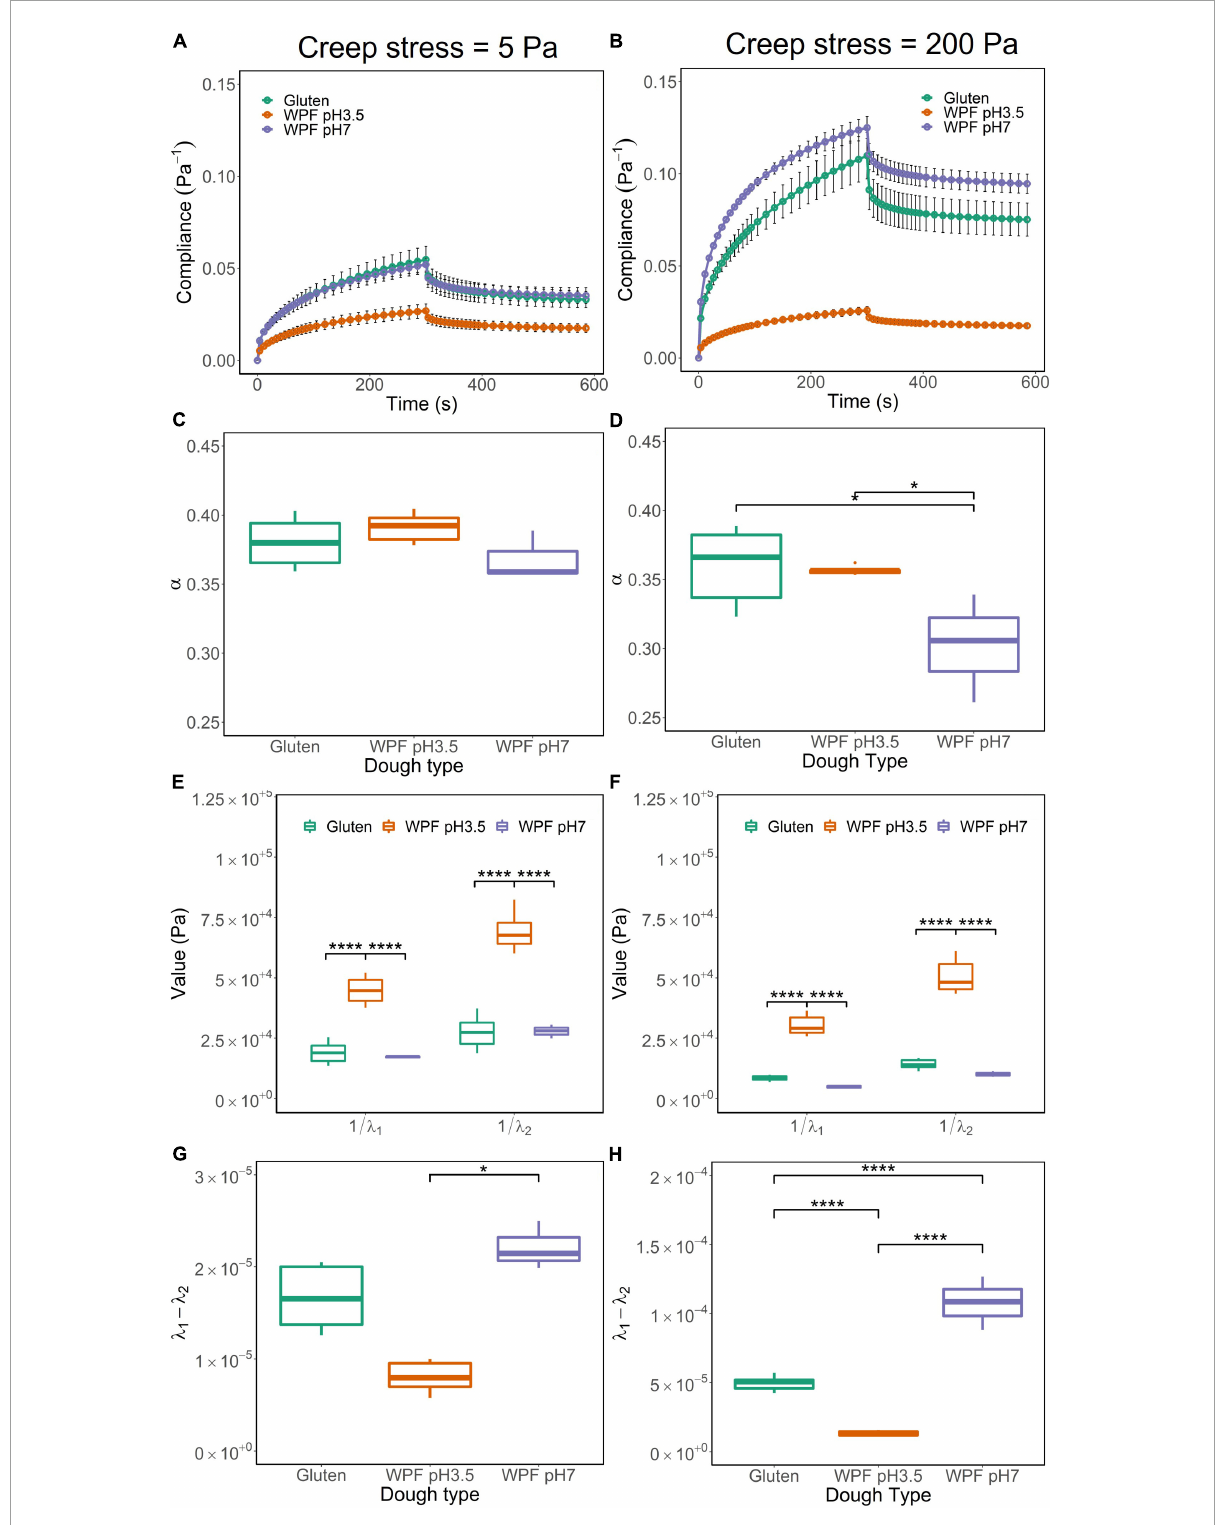
FIGURE5 Creep-recovery curves, parameters from the fitted model, including α , the inverse of λ 1 and λ 2 , and the difference between λ 1 and λ 2 for gluten, WPF pH3.5, and WPF pH7 doughs under creep stress at 5 Pa (A,C,E,G) and 200 Pa (B,D,F,H) . The error bar represents the standard error. Asterisks (*) indicate the significant difference between values (* p ≤ 0.05, **** p ≤